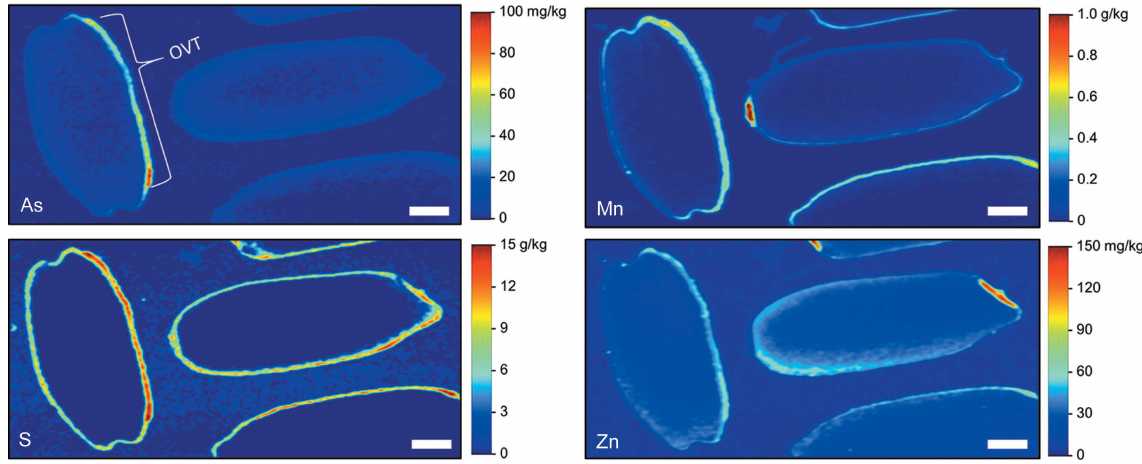
Figure 5 Quantitative SR- m XRF elemental concentrations in the longitudinal section of rice grains grown in soil with elevated levels of As ( (cid:3) 24 mg kg (cid:2) 1 ). Scale bar denotes 1 mm.